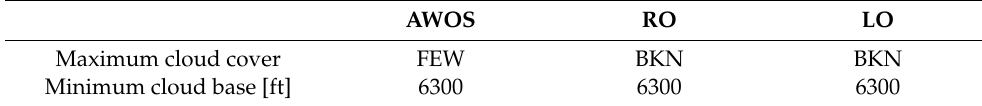
Table 6. The same as Table 4, but for 21 September 2018, at 09:20 UTC. BKN—Broken.